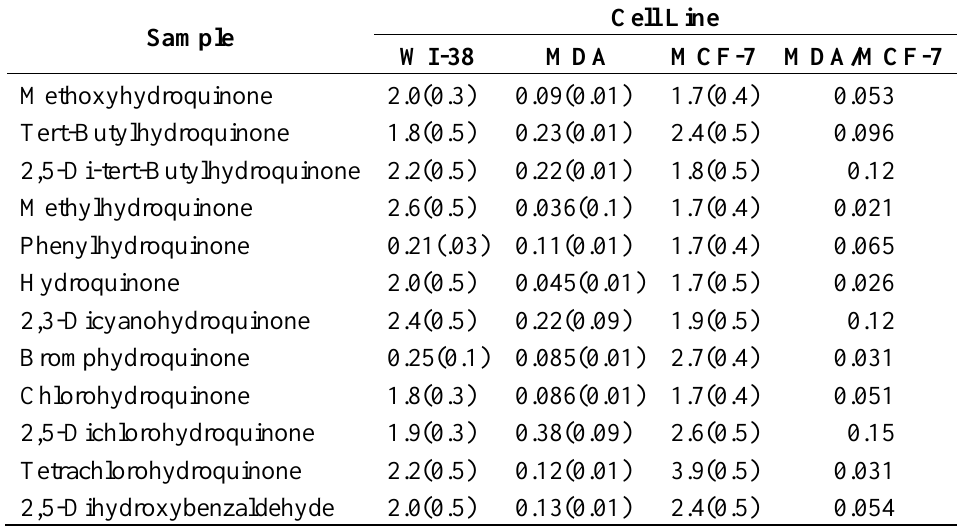
3. GI concentrations (micrograms/mL) for dibutyltin polyethers from 50 hydroquinone and hydroquinone derivatives for MDA and MCF-7 cell lines.